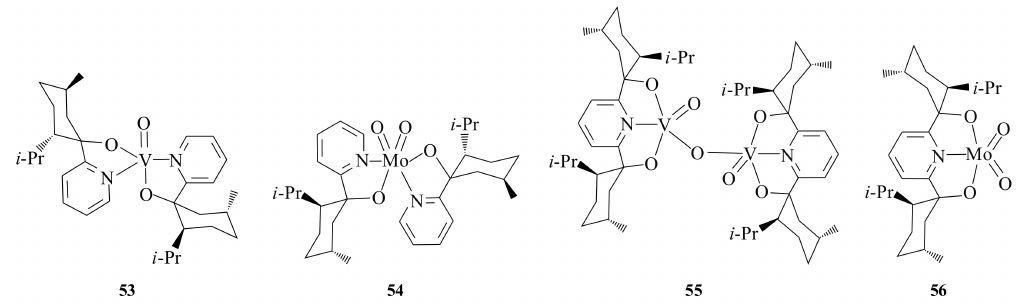
Figure 10. Multidentate catalysts for regioselective